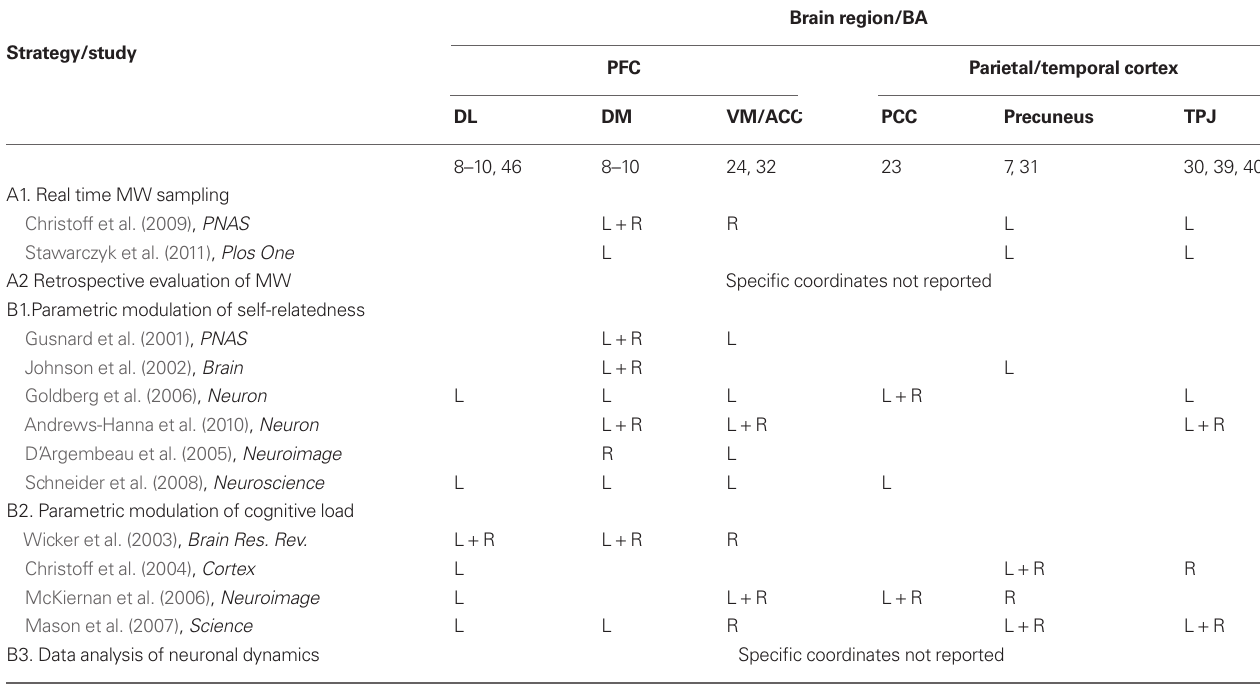
Table 1 | A summary of overviewed studies and their DMN-related